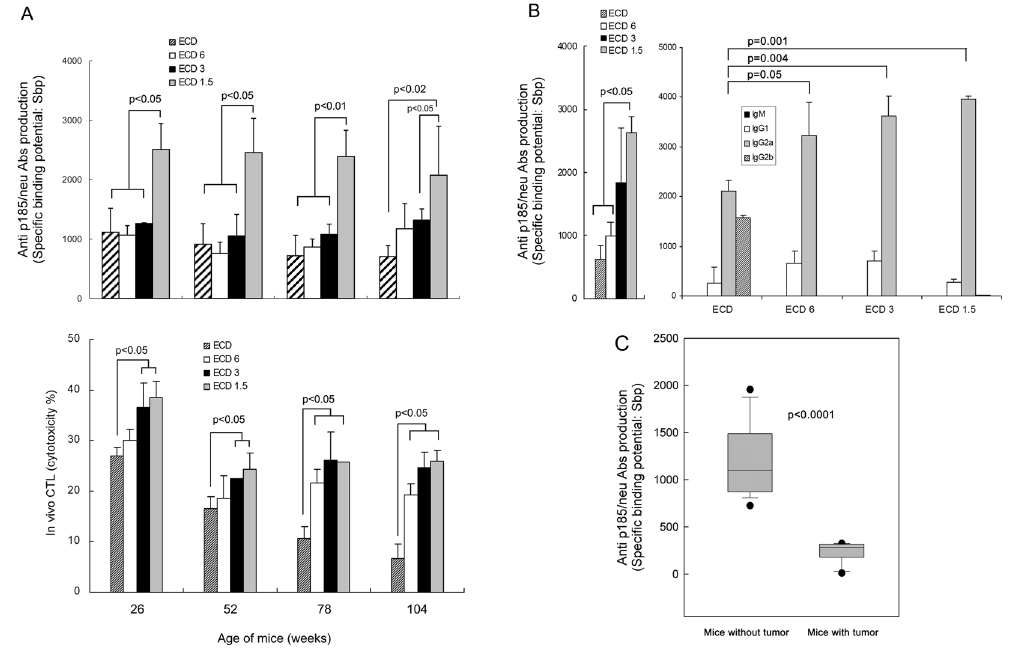
Figure 3. Presence of anti p185neu Abs and in vivo cytotoxicity in HER-2/ neu transgenic mice after BI. Sbp of sera to p185 protein ( A , top) or in vivo cytotoxicity ( A , bottom) from three animals of SI and BI groups were analysed at all time points reported. The ability of sera to bind p185 neu (Sbp) was evaluated by flow cytometry as reported in M&M. For cytotoxicity, immunized mice of different age were injected with CFSE stained splenocytes from naıve transgenic mice pulsed with either HER-2 immunodominant or irrelevant peptides and were analyzed by flow cytometry as detailed in M&M.; anti-p185 neu IgM or IgGs isotytpes were analysed in three mice of SI and BI groups at 39 weeks of age ( B ); p185 protein in 104 weeks old-mice of ECD1.5 group with or without tumour are shown ( C